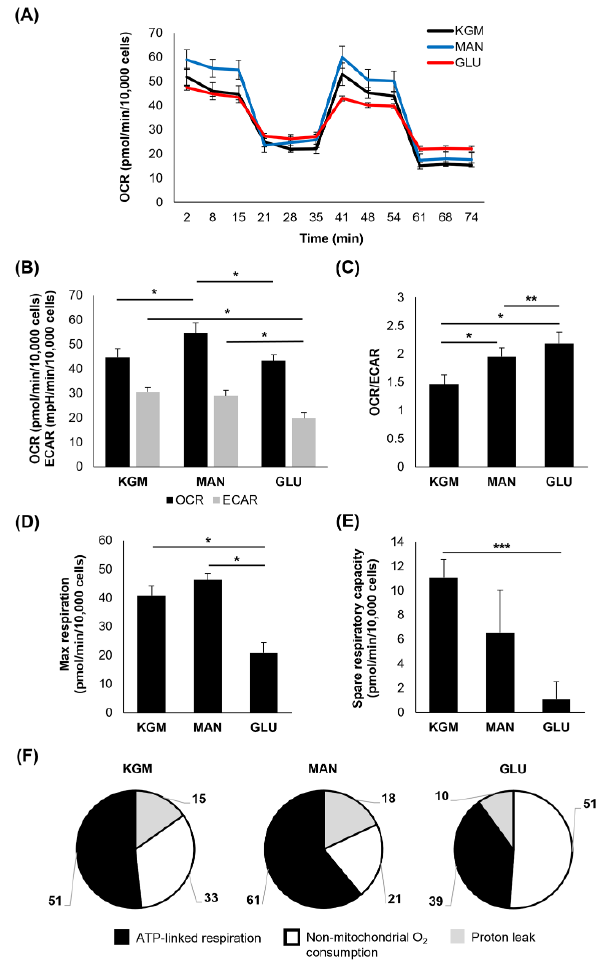
Figure 2. Hyperglycemia decreased both glycolysis and spare respiratory capacity after 5 days of culture. ( A ) OCR plotted as a function of time for both test and control groups. ( B ) OCR was only increased in mannitol-treated cells (* p < 0.001). In contrast, ECAR was decreased in cells cultured in high glucose (* p < 0.001). ( C ) The OCR/ECAR ratio shifted toward a more respiratory phenotype in cells cultured in high glucose (* p < 0.001). Mannitol-treated cells were more respiratory than cells in KGM but did not reach the same threshold as cells cultured in high glucose (** p = 0.038). ( D ) There was a decrease in maximal respiration in cells cultured in high glucose (* p < 0.001). ( E ) Spare respiratory capacity was similarly decreased in cells cultured in high glucose (*** p < 0.05). ( F ) The proportion of oxygen consumption due to ATP-linked respiration, non-mitochondrial oxygen consumption, and the proton leak in the KGM control compared to glucose- and mannitol-treated cells. Bar graphs are presented as mean ± standard deviation. Pie charts are presented as percentage of total oxygen consumption. Graphs are representative of one experiment that was repeated three independent times. One-way ANOVA on ranks with Dunn’s post hoc comparison test (spare respiratory capacity and proton leak) and one-way ANOVA with SNK multiple comparison test for all others.